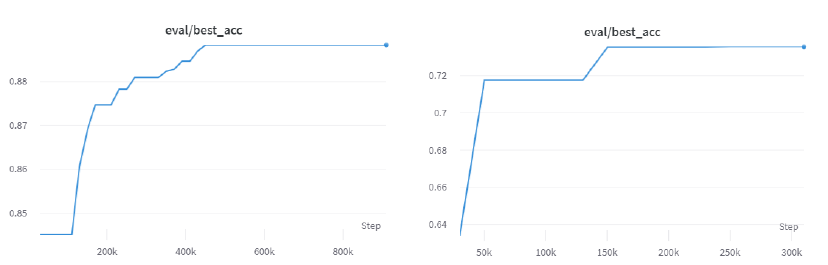
Figure 12. Best training and evaluation accuracy in ‘Experiment 8’ and ‘Experiment 10’.